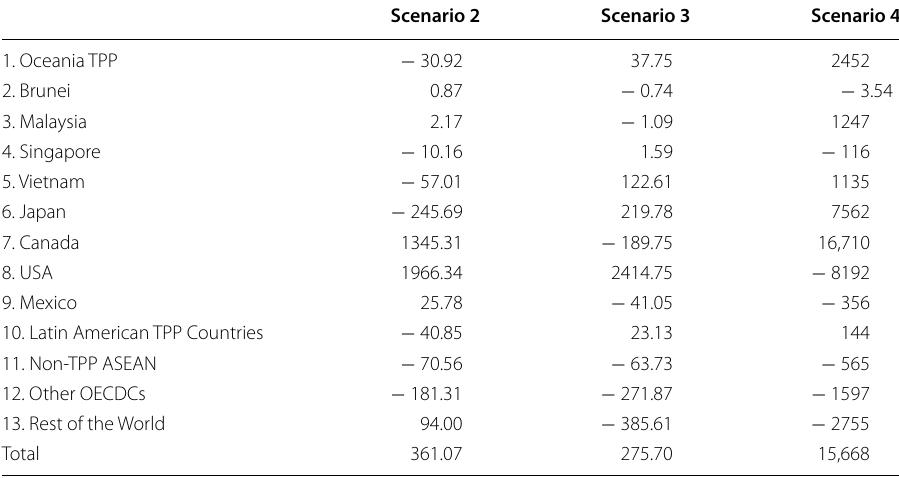
Table 11 Total welfare impact of the Other TPP members and Rest of the World